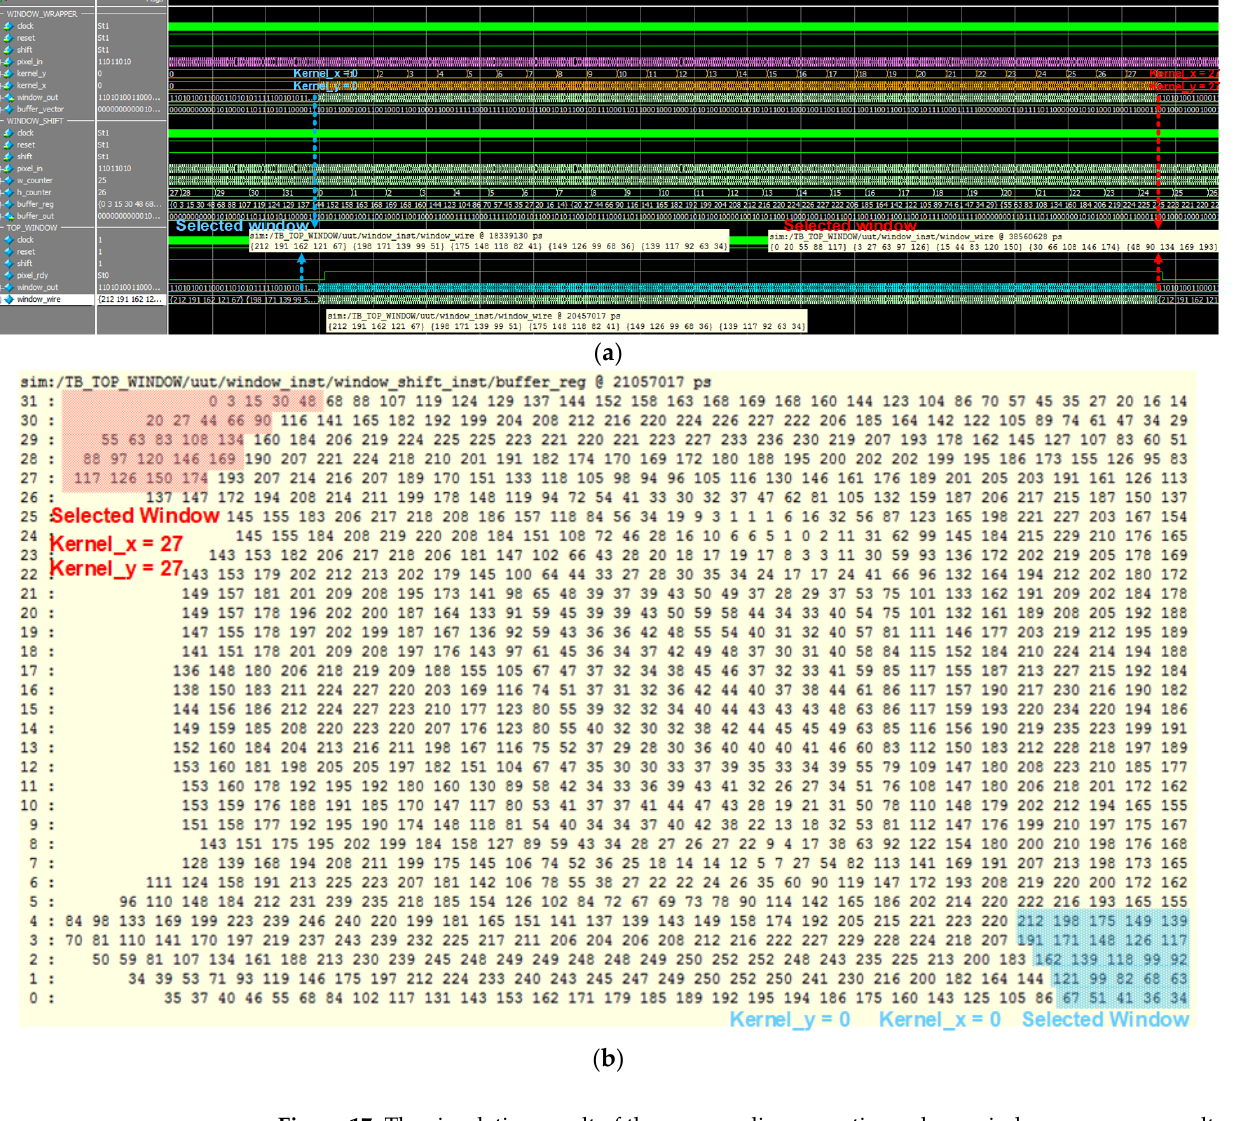
Figure 17. The simulation result of the max-pooling operation, where windows wrapper results are shown in ( a ) Simulation result of window wrapper, while data of one selected image is shown in ( b ) One image data with selected window.